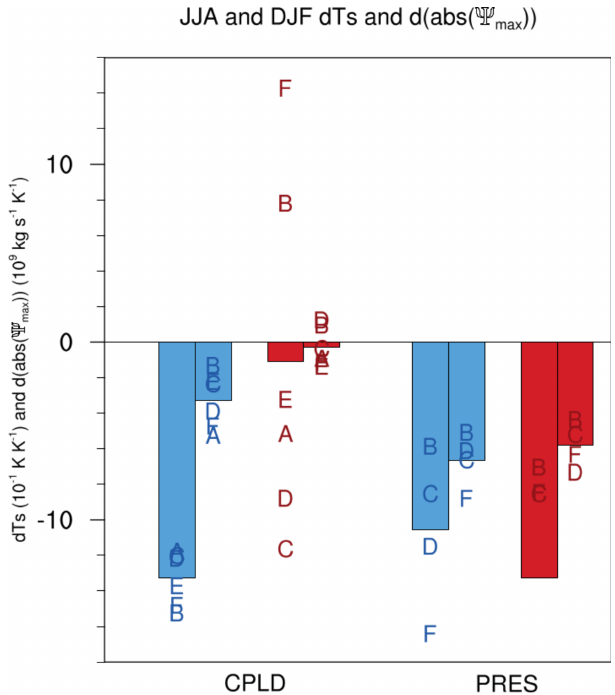
Figure 6. CPLD and PRES multi-model mean DJF (blue) and JJA (red) (cid:49) | (cid:57) | max (left bar of pair) and (cid:49) Ts (right bar of pair), with individual models indicated by letters (see Table 1 and text for de-